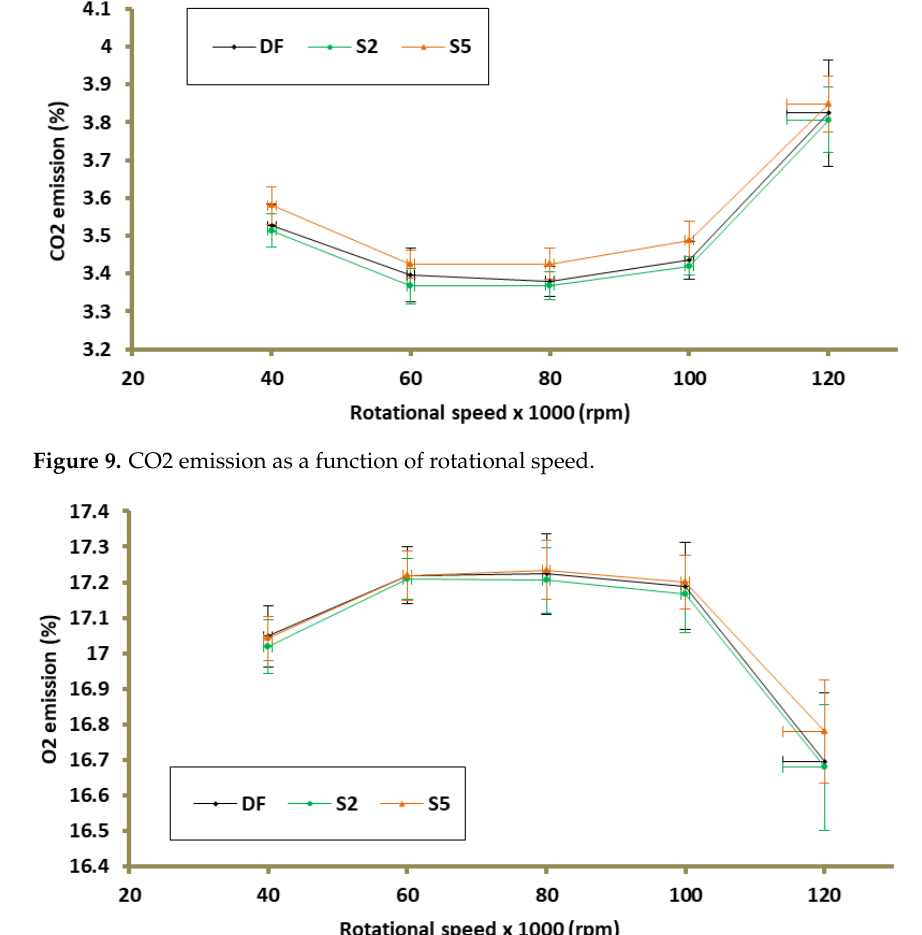
Figure 8. CO emission depending on the rotational speed.